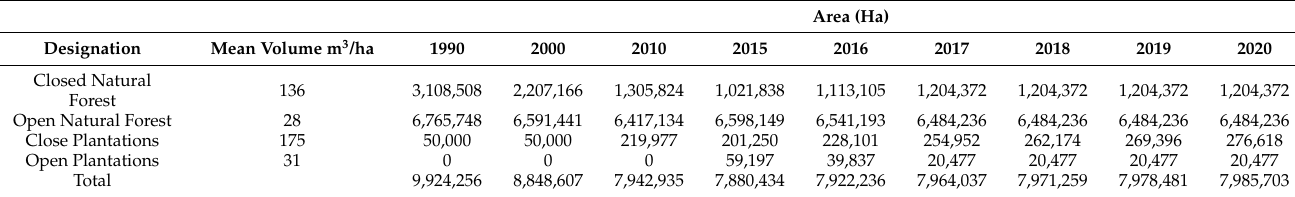
Table 1. Mean volume m 3 /ha estimates for four key forest types in Ghana 1990–2020.